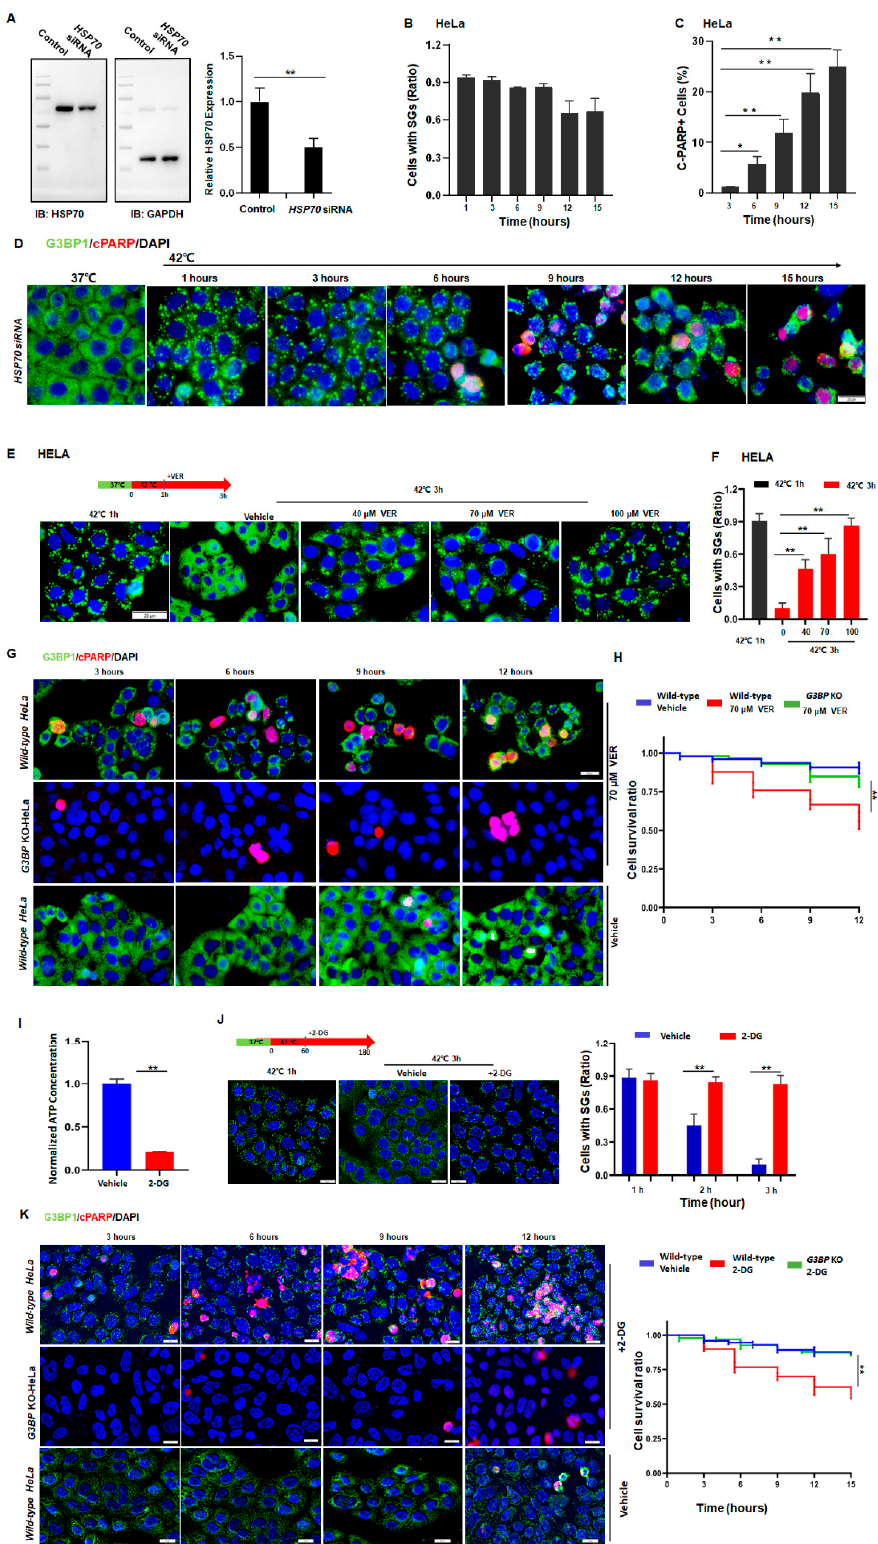
Figure 4. Cancer cells sneak under stress past the protein quality control system by promoting HSP70-dependent SG clearance. ( A ) HSP70 in HELA cells treated with control or HSP70 siRNA. Mean ± SEM. ** p < 0.01 (Student’s t -test). ( B ) SGs ratio in HeLa cells treated with HSP70 siRNA ex- posed to 42 ◦ C stress for the indicated time. Mean ± SEM. No significance (ANOVA test). ( C , D )